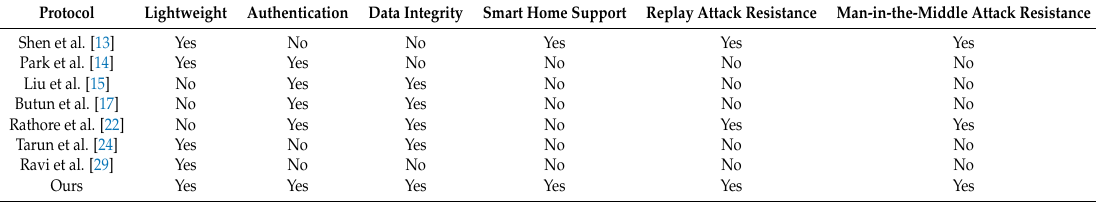
Table 5. A comprehensive comparison between different protocols.